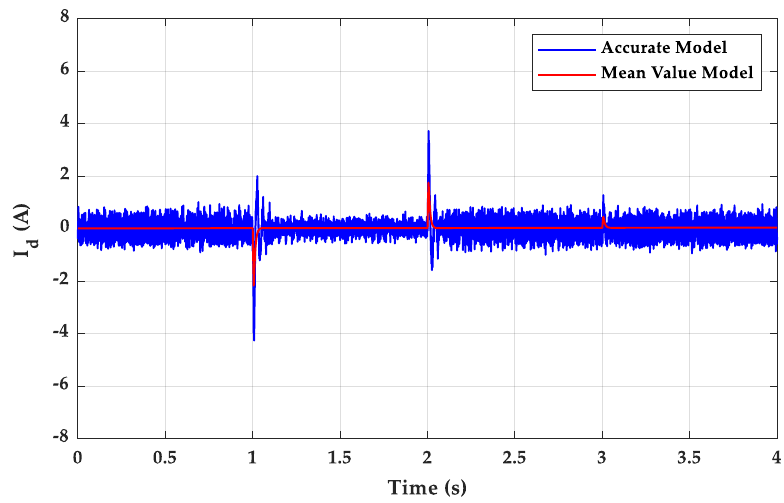
Figure 5. The VSI output d -axis current component.